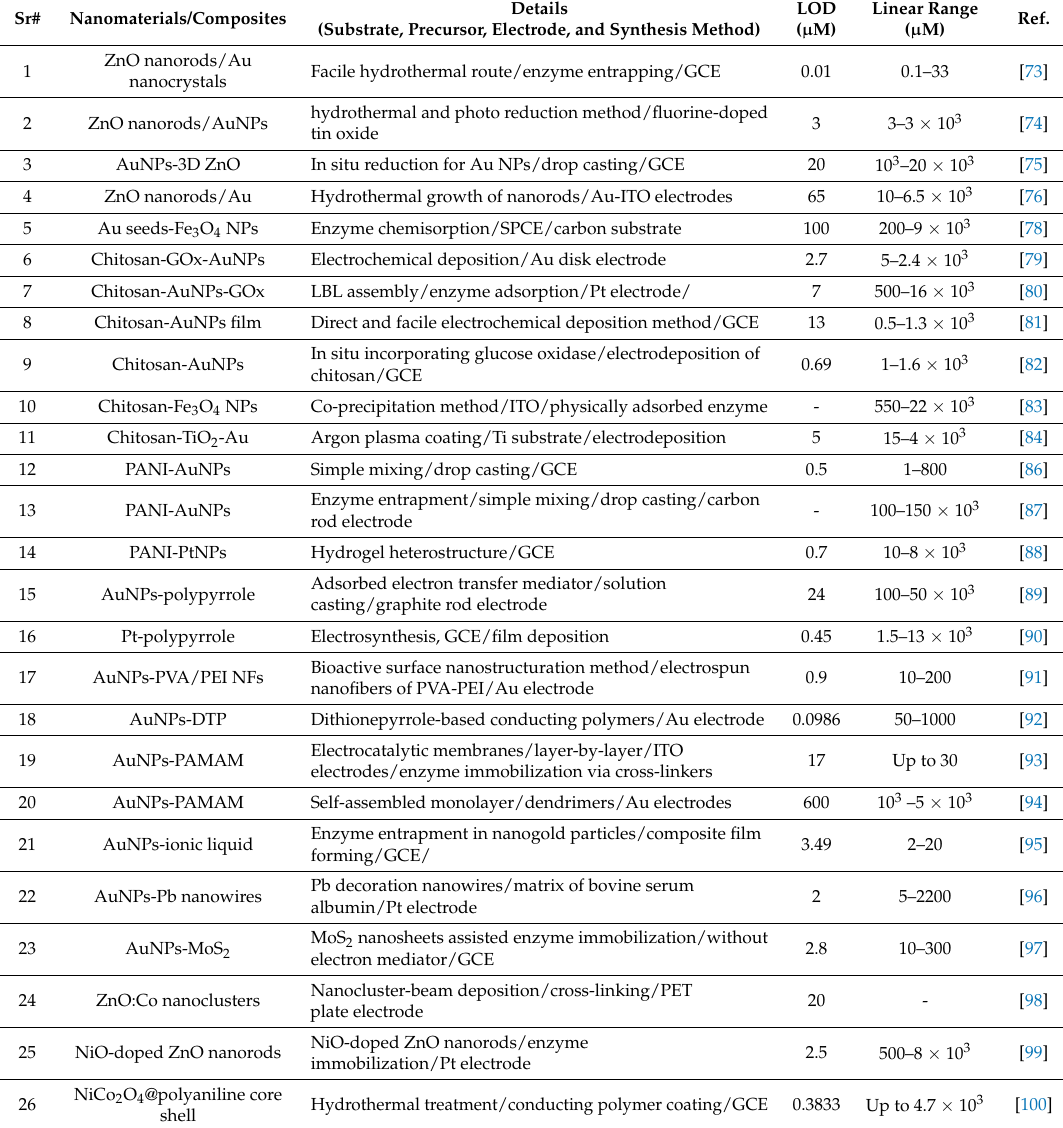
Table 2. Electrochemical glucose sensors based on metallic